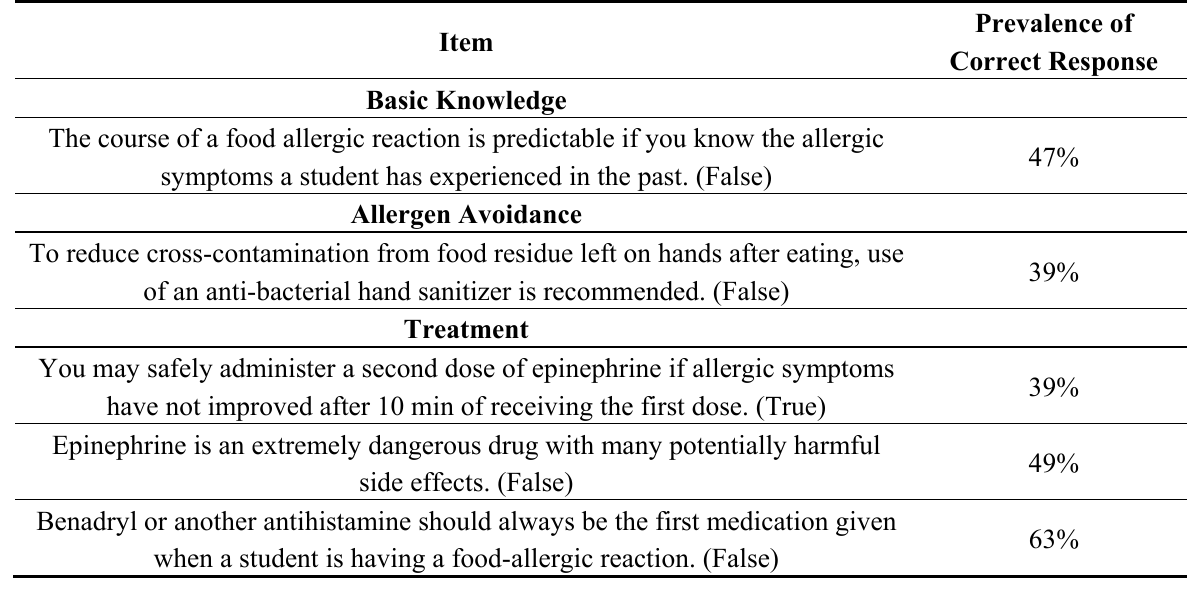
Table 3. Food allergy knowledge